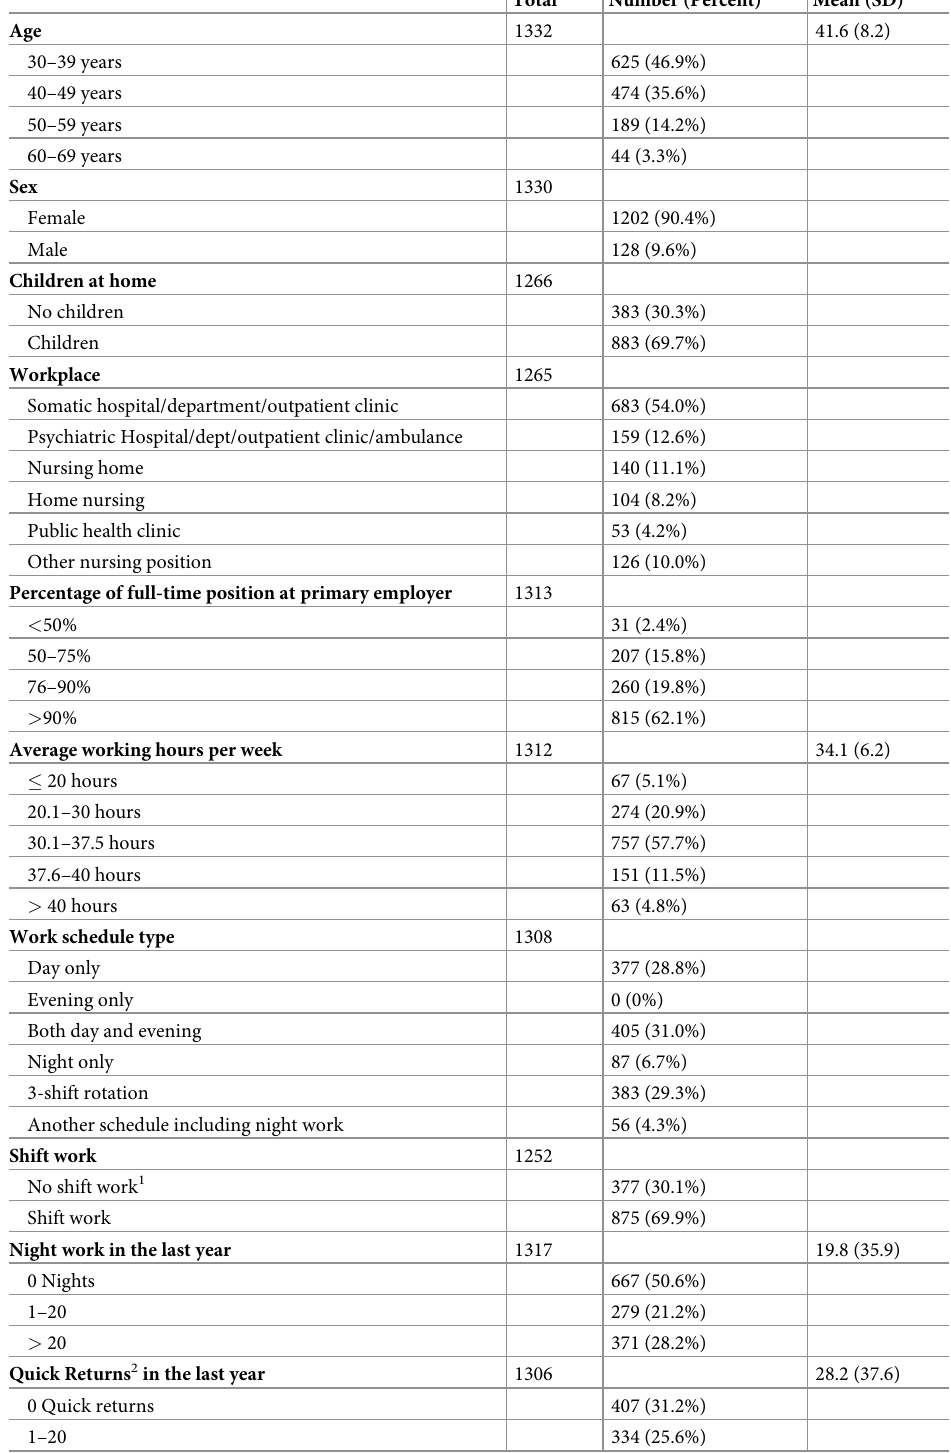
Table 1. Demographics and work-related variables among 1335 Norwegian nurses participating in the survey of shift work, sleep and health wave 10